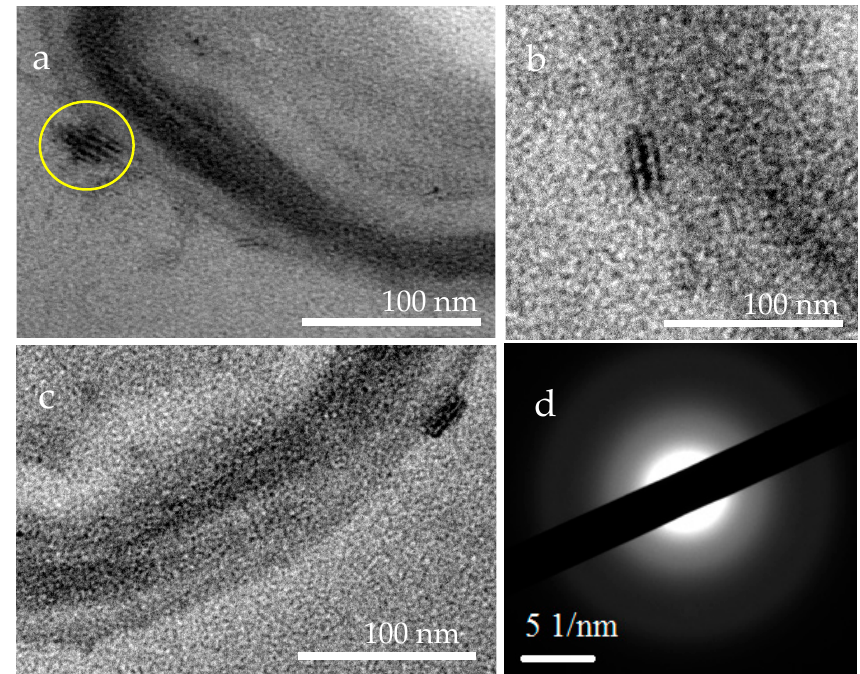
Figure 10. The dark clumps composed of alternating light and dark bands within the EPS of B. licheniformis analyzed by HRTEM and SAED. ( a – c) images of the dark clumps analyzed by HRTEM, ( d ) SAED image of the dark clump marked by the yellow circle in ( a